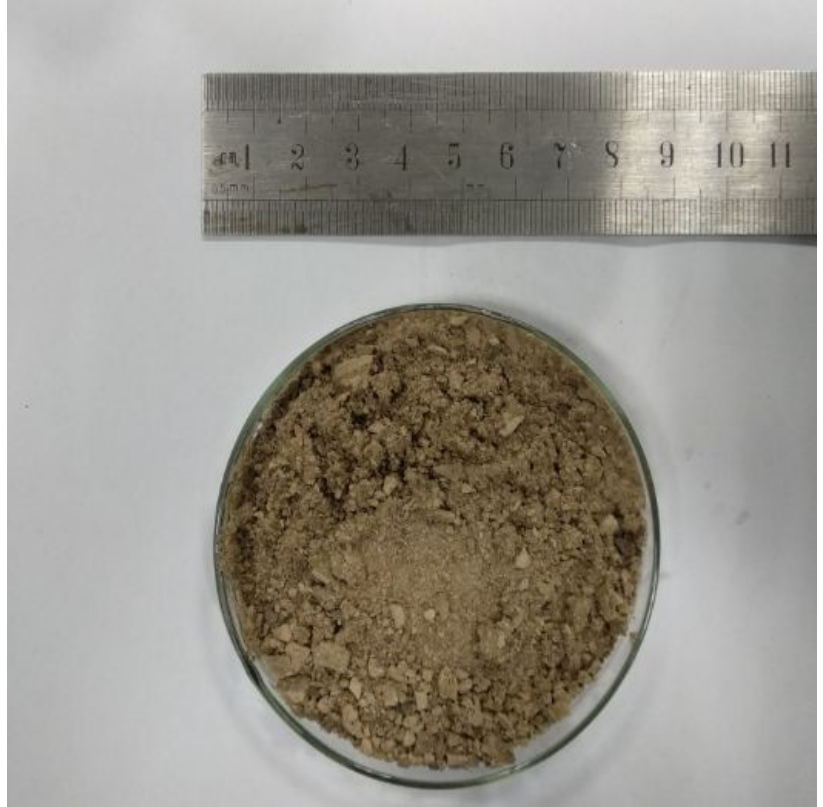
Figure 9. Specimen in the high-temperature stage.